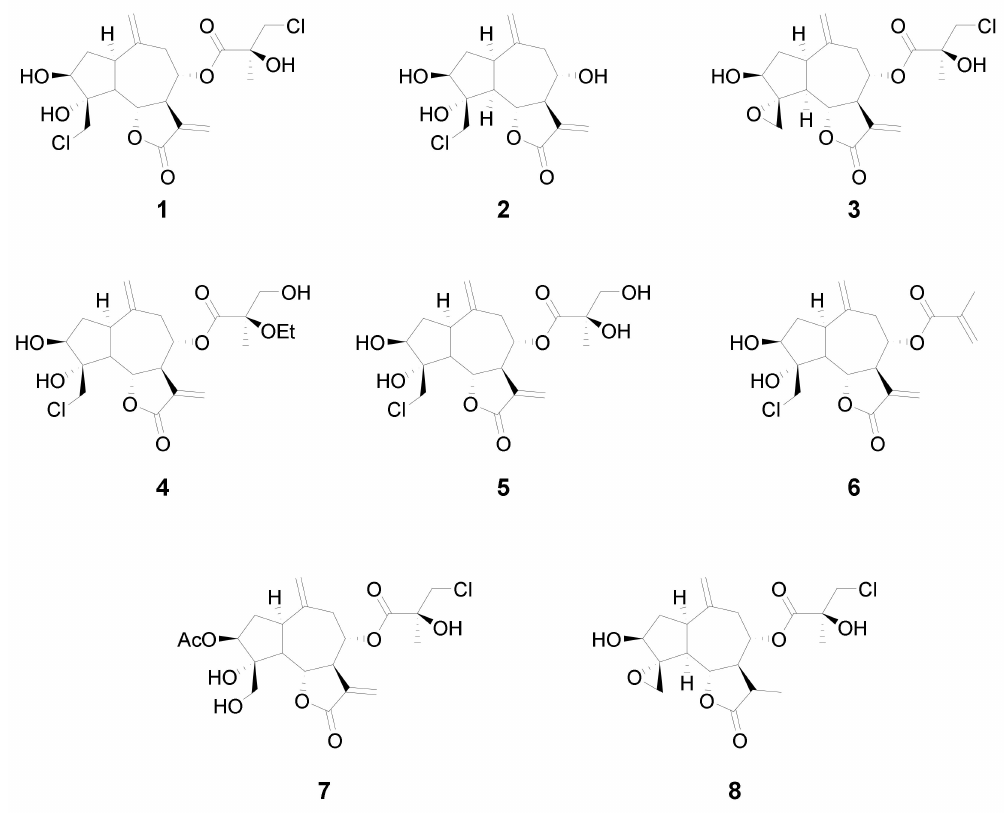
Figure 1. Chemical structures of the guaianolides